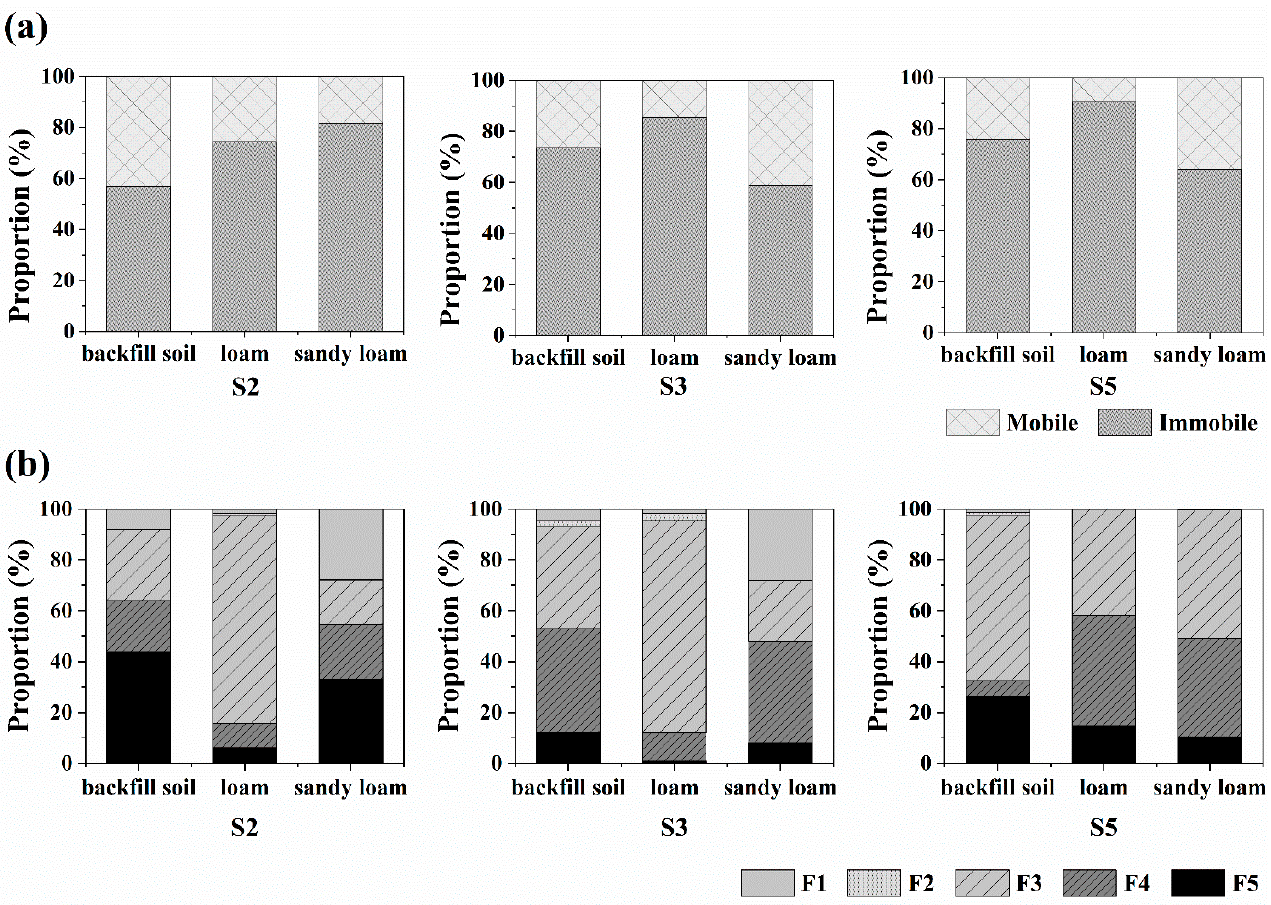
Figure 6. The chemical fractions of Cr(VI) ( a ) and total Cr ( b ) based on sequential extraction. From the outset, Cr(VI) was the main pollutant and contributor to leaching toxicity.